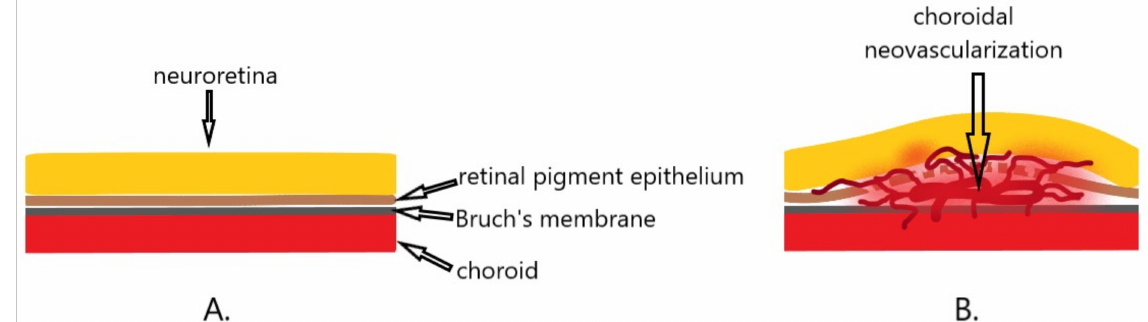
Figure 5. Diagram of choroidal neovascularization. ( A ). Normally, the Bruch’s membrane and the retinal pigment epithelium separate the neuroretina from the choroid. ( B ). Disturbances in homeostasis result in the formation of abnormal blood vessels that overgrow Bruch’s membrane and spread under the pigment epithelium and in the subretinal space, causing neuroretina elevation and swelling.